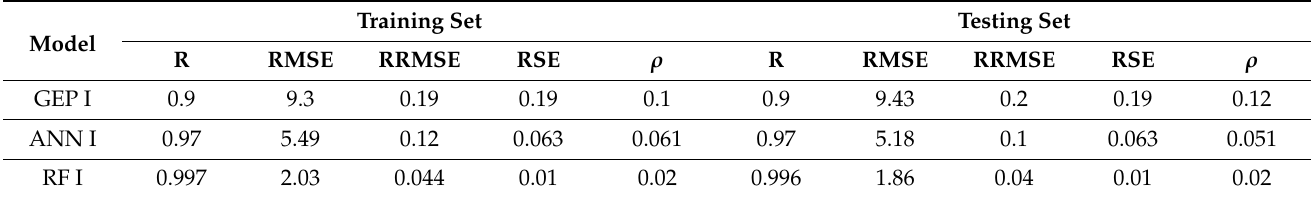
Table 4. Statistical evaluation of GEP I, ANN I, and RF I.